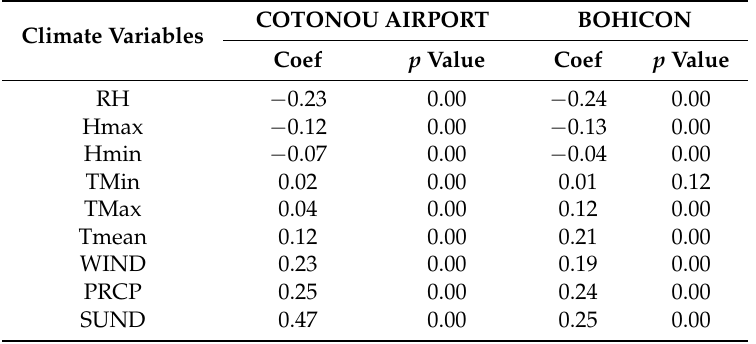
Table 13. Correlation coefficient of pan evaporation with mean relative humidity (RH), maximal relative humidity (Hmax), minimal relative humidity (Hmin), minimal temperature (Tmin), maximal (PRCP), and sunshine duration (SUND).